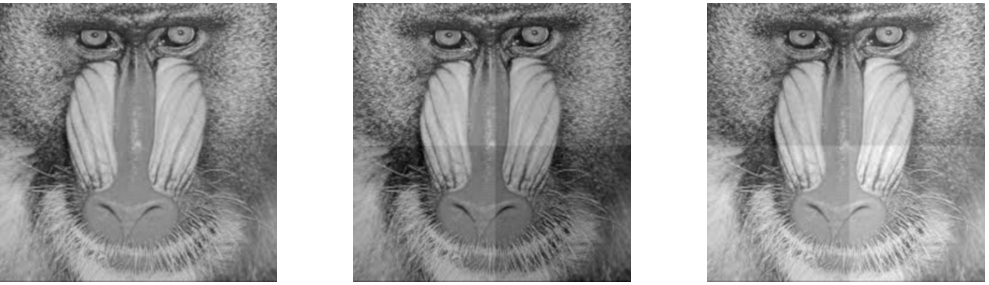
Figure 1. Baboon ( left ); The images generated by u 1 ( center ) and u 2 ( right ) using the interval valued multifunction (7), with β defined in